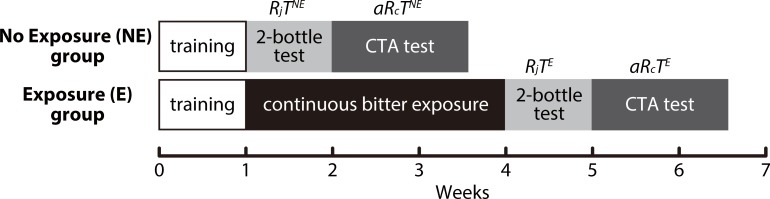
Typical experimental schedules for the measurement of rejection (RjT) and apparent recognition (aRcT) thresholds for bitter compounds.RjTNE and aRcTNE are defined as values measured without 3 weeks of a bitter exposure period (NE group), whereas RjTE and aRcTE as values measured after the continuous bitter exposure period (E group).